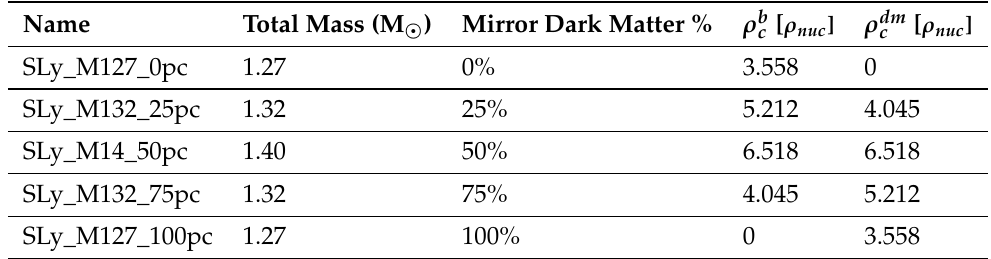
Figure 3. Left : Time evolution of the central density of baryonic matter (blue) and mirror dark matter (red) for the four different resolutions presented in this section. Right : Time evolution of the L2-norm of the Hamiltonian constraint for R1, R2, R3, and R4. The convergence order for the three highest resolutions is two. In all these runs the star is 50% dark matter admixed and has a total gravitational mass of 1.4 M (cid:12) and a baryonic mass of 1.56 M (cid:12) . Table 1. Initial data, for convergence tests carried out with single mirror dark matter admixed neutron stars; cf. main text for further